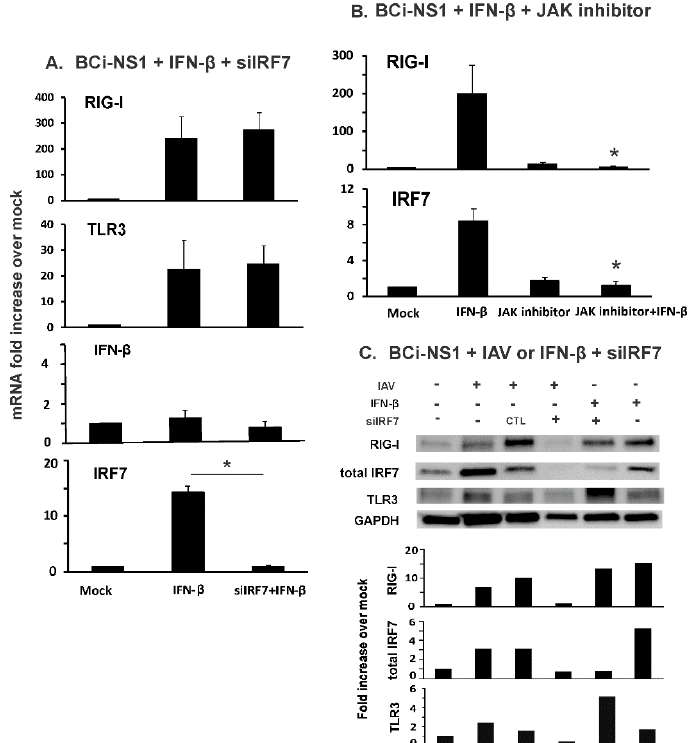
Figure 2. Knockdown of IRF7 did not inhibit IFN-β-mediated RIG-I and TLR3 induction in BCi-NS1.1 cells. BCi-NS1.1 cells were transfected with IRF7 siRNA for three days ( A ), or were treated